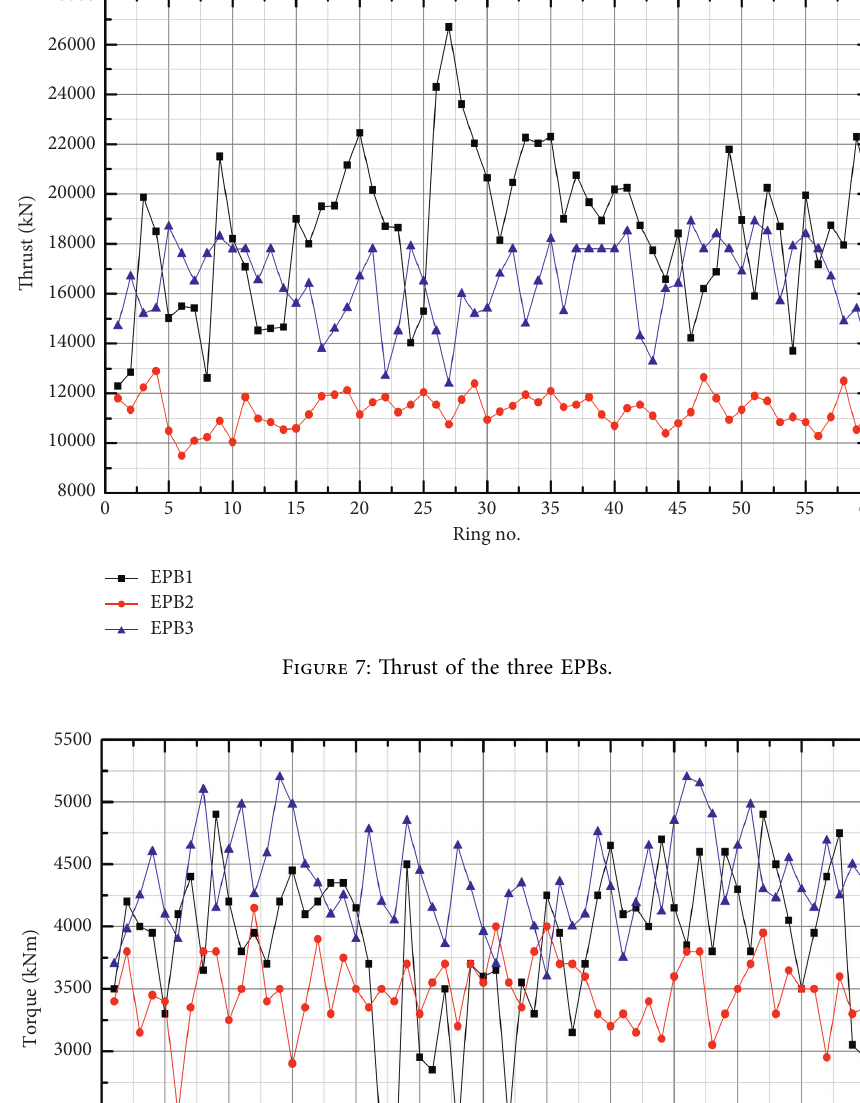
Figure 8: Torque of the three EPBs.